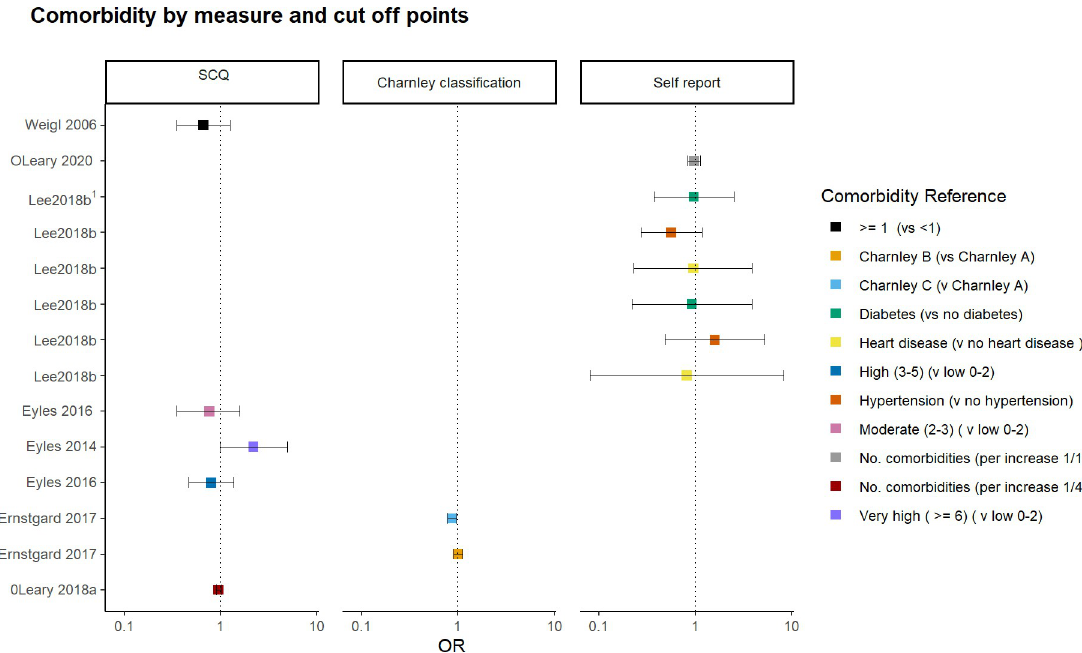
Fig 5. Presence of comorbidity on the odds of a positive outcome following a combined first- intervention for knee osteoarthritis. Graph reports the log odds ratio and 95% CI. Repeated study labels by the same author represent multiple responder definitions within each study. OR > 1 for comorbidity interpreted as increased probability of being a responder with the presence of comorbidity. For a continuous predictor, we interpret the log-odds change with a one-unit change in comorbidity score. For dichotomised predictor, the OR is the probability of the comorbidity category to the reference group of being a responder. Original data from 7 studies reporting OR. Studies not included:2 reporting regression coefficient [25, 47], 2 mean differences [37, 41] and 1 unadjusted hazard ratio [36]. SCG = self- administered comorbidity questionnaire. Charnley classification = Charnley A (unilateral hip or knee OA), B (bilateral hip or knee OA), C (multiple joint sites hip and knee and presence of other disease affecting walking ability). Self-report = presence of one comorbidity or number of self-reported comorbidities.1. Lee2018b used multinomial logistical regression with multiple outcome definitions based on four group-based trajectories of WOMAC pain and function. OR > 1 indicates an increased probability of being in the lower pain, early improvement group. 2. There are six OR reported for Eyles (2016) due to multiple responder definitions and the number of comorbidities reported as low, moderate, and high.